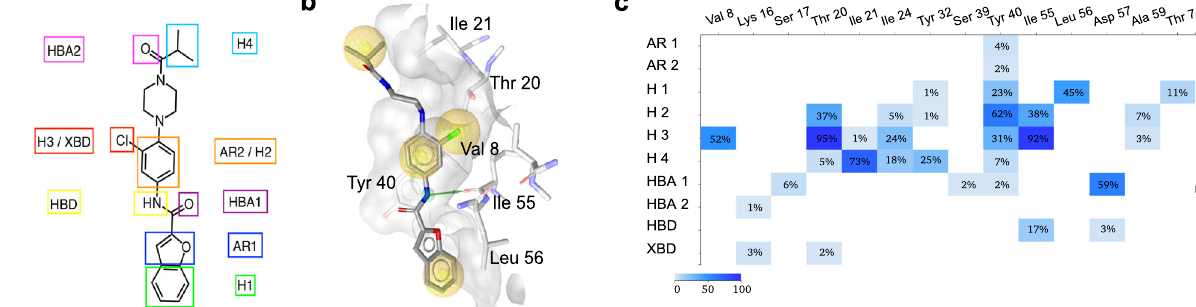
Fig. 7 In silico assessment of Rasar fi n interactions with Ras. a 2D structure of Rasar fi n labeled with established pharmacophoric features interacting with Ras residues. AR1-2 aromatic feature, H1-H4 hydrophobic feature, HBA1-2 hydrogen bond-acceptor, HBD hydrogen bond donor, XBD halogen bond donor. b Stick representation of Rasar fi n embedded in the binding pocket of Ras (transparent gray) with interacting Ras residues labeled. Yellow spheres correspond to H1-H4; green arrow shows HBD of Rasar fi n interacting with Ile55 backbone carbonyl. c Plot of interaction frequencies between residues of Ras ( x -axis) and the pharmacophoric features of Rasar fi n ( y -axis). Color coding according to interaction